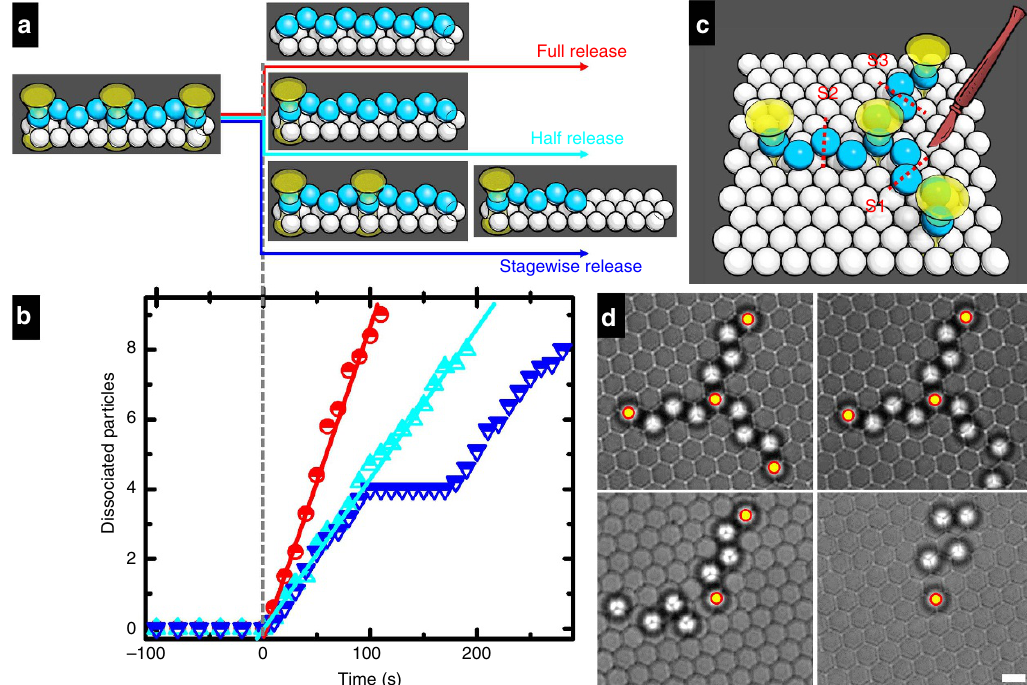
Figure 4 | Two examples of vector disassembly. ( a ) A scheme to disassemble a three-tweezer stabilized zigzag chain by unclicking the tweezers in three different manners. Full release, removing all the three tweezers at time 0 (red); half release, unclicking the end and middle tweezers at time 0 (cyan); and stagewise release, withdrawing the end tweezer at time 0 and middle tweezer at 160s (blue). ( b ) The number of dissociated particles against time. Points are experimental data and straight lines linear fitting with colour coding the same as that of ( a ). The satisfactory linear fitting indicates that the particles detach from the chain end one by one at a statistically constant rate. The particle dissociation times are B 12 and 23s for the red and cyan lines, respectively. ( c ) A scheme to surgically cutoff a three-arm structure in three steps (S1 to S3). ( d ) Four snapshots of the disassembly process with yellow– red circles highlighting the operating optical tweezers. Scale bar, 3 m